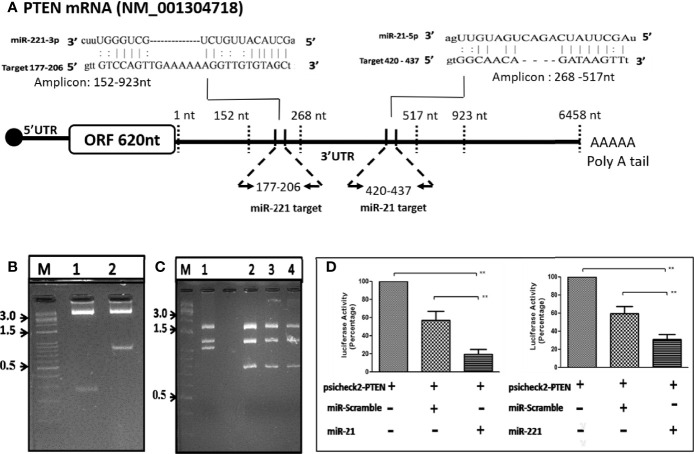
OncomiR target validation by Luciferase reporter 3’-UTR assay. (A) Schematic depiction of PTEN UTR as miR-21 and -221 targets through bioinformatic analysis. (B) Direction cloning of PTEN 3’-UTR in psiCheck-2 vector as target for miR-21 (Lane 1) and miR-221 (Lane 2) and confirmed by double digestion with XhoI/NotI. (C) Cloning of short hairpin miR precursor in psiRNA-h7SKGFPzeo vector at BbsI. Positive clones are confirmed by digestion with SpeI (Lanes 1, no insert; 2, miR 21; 3, miR-221; 4, miR-Scr). (D) Luciferase reporter 3’-UTR assay for target validation of miR-21 and miR-221. **P ≤ 0.01.